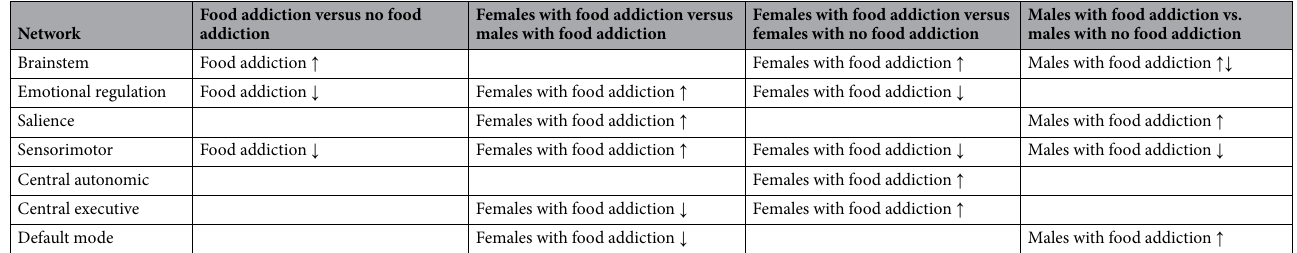
Table 5. Summary of all group comparisons in network connectivity (food addiction and sex). Summarizes the group (disease effect, sex effect, and within-sex contrasts) network connectivity differences. ↑ , Greater connectivity; ↓ , Lower